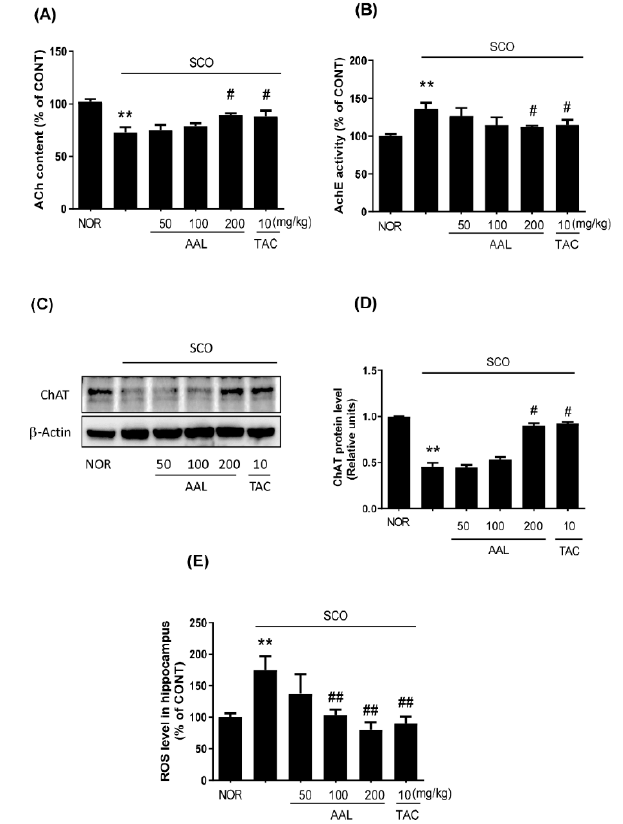
Figure 4. Effect of AAL extract on cholinergic system dysfunction and ROS production in scopolamine-induced cognitive deficit mouse brains. ACh content ( A ) and AChE activity ( B ) were measured in the hippocampus using an ACh and AChE activity assay kit (US Biomax Inc., Rockville, MD, USA). Hippocampus tissue was lysed and subjected to Western blotting with anti-ChAT antibody ( C ). Expression levels were normalized to β -actin. Bar graphs represent the relative band intensities compared with NOR ( D ). ROS levels in hippocampal tissue were measured using an ROS/RNS assay kit (Cell Biolabs, Inc., Sandiego, CA, USA). The fluorescence intensities corresponding to the ROS levels in the hippocampus are represented as a percentage of that in the NOR ( E ). Data are presented as the mean ± SEM ( n = 5). ** p < 0.01 vs. NOR group, # p < 0.05 or ## p < 0.01 vs. SCO group. NOR: normal control; SCO: scopolamine; AAL: A. atemoya leaf; TAC: tacrine.